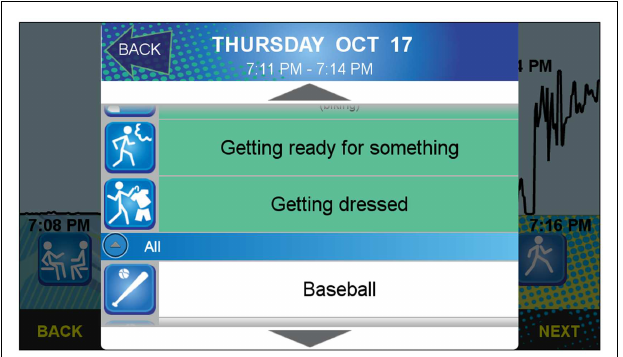
with the respective activity icon. The participant may change his or her selection at any time by touching any existing icon